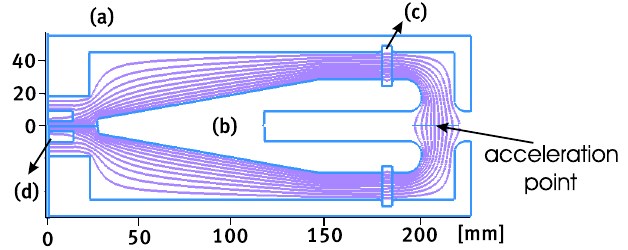
FIG. 2. (Color) Equipotential field lines inside the accelerating structure calculated with SUPERFISH . (a) outer conductor; (b) inner conductor; (c) glass ring; (d) ceramic of the high voltage